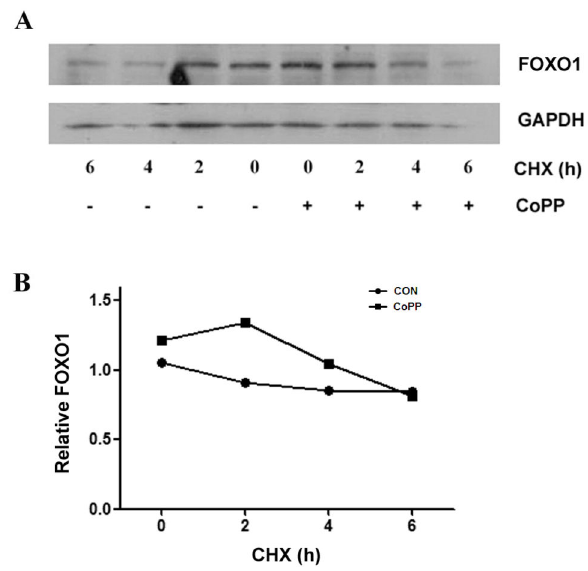
Figure 4. CoPP has no influence on FOXO1 protein stability. Primary hepatocytes are treated with or without 10 µM CoPP for 16 h, followed by treatment with 100 µg/ml cycloheximide (CHX) for the indicated times, after which cells are harvested and total protein is isolated as described in Materials and Methods. Proteins are separated by 10% SDS- polyacrylamide gel, transferred to a PVDF membrane, and probed with anti-mouse FOXO1 and GAPDH specific antibodies. (A) FOXO1 protein levels with or without CoPP. (B)The relative amounts of FOXO1 proteins are normalized to